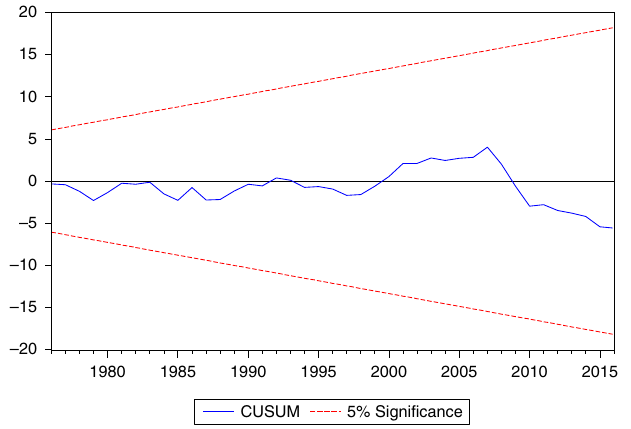
Figure 3. Plot of cumulative sum of recursive